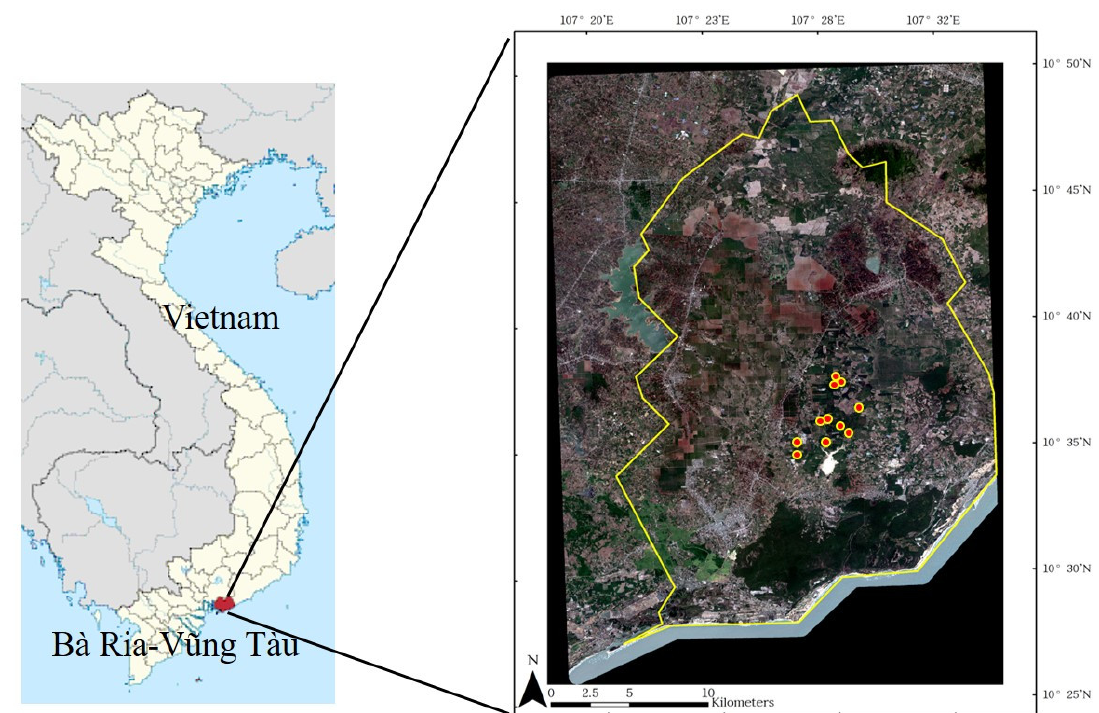
Figure 1. Location of plots for the study site. The red circles with yellow borders in the right-hand figure indicate the locations of the plots where forest surveys were conducted.